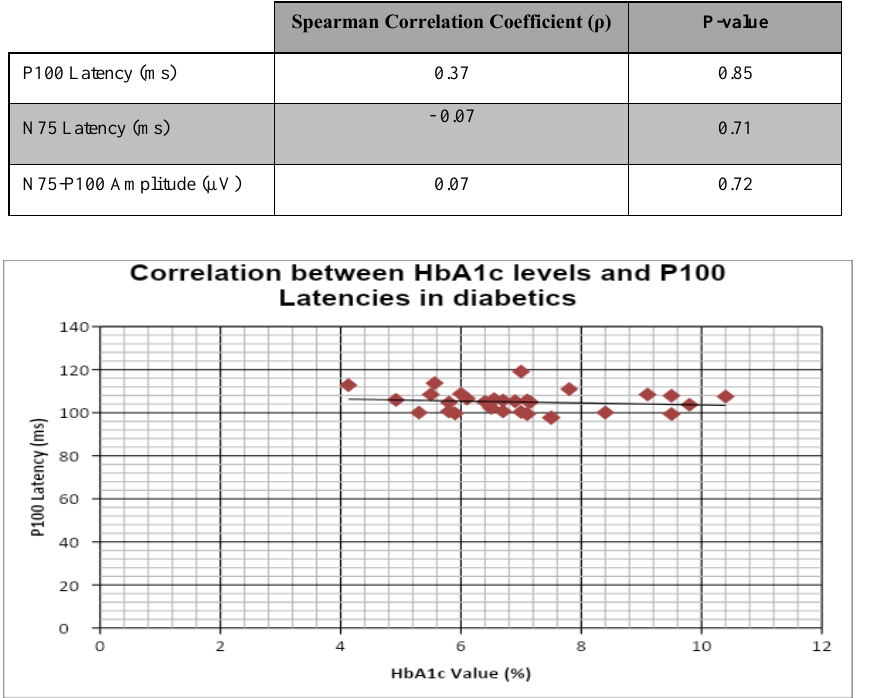
Table 11. Correlation between HbA1c level and mean VEP wave latencies and amplitude in diabetics cases.